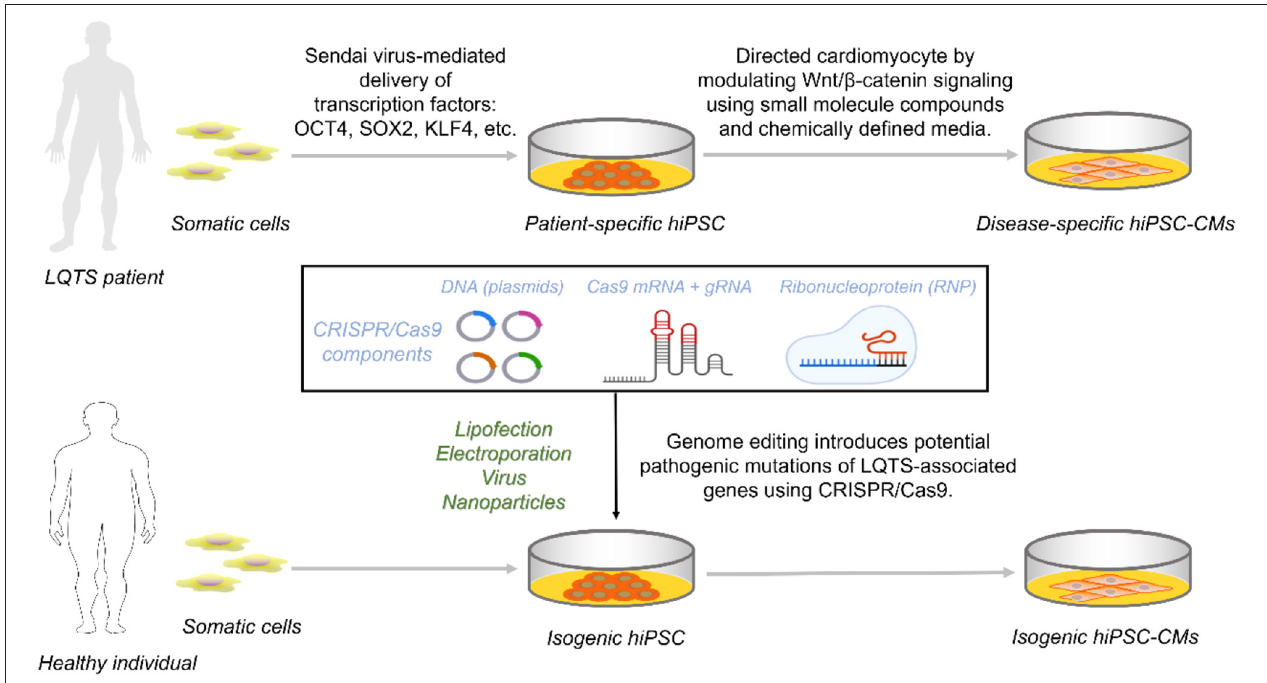
FIGURE 1 | Access to disease-specific hiPSC-CMs from LQTS patients and isogenic cell lines by CRISPR/Cas9. Reprogramming somatic cells from healthy individuals or patients with transcription factors generates hiPSCs that are further targeted to inhibit Wnt/ β -catenin capable of directed differentiation into hiPSC-CMs carrying the genetic information. For hiPSCs from healthy individuals, constructing an isogenic set as control requires the introduction of one of the three CRISPR/Cas9 components into the cell via a different